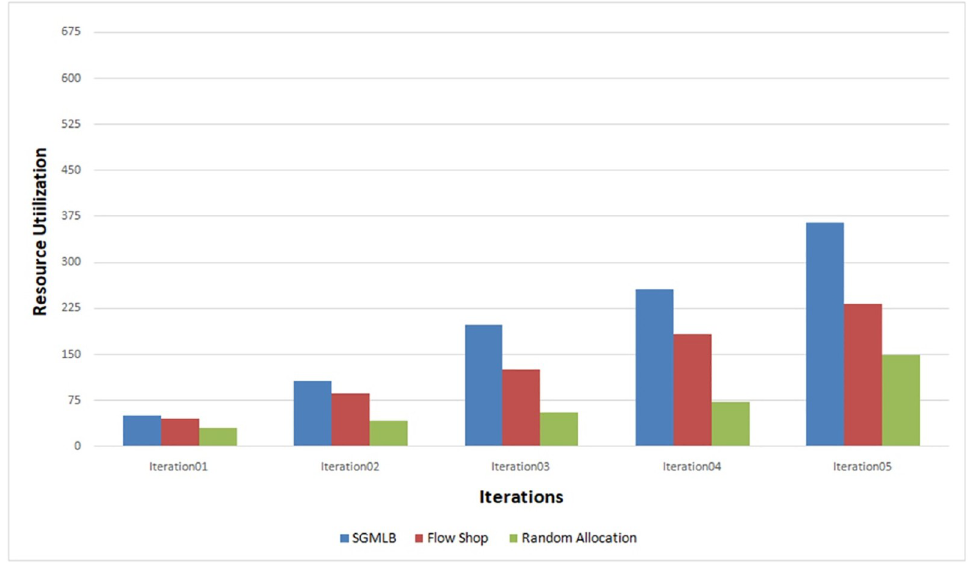
Fig 6. Resource utilization